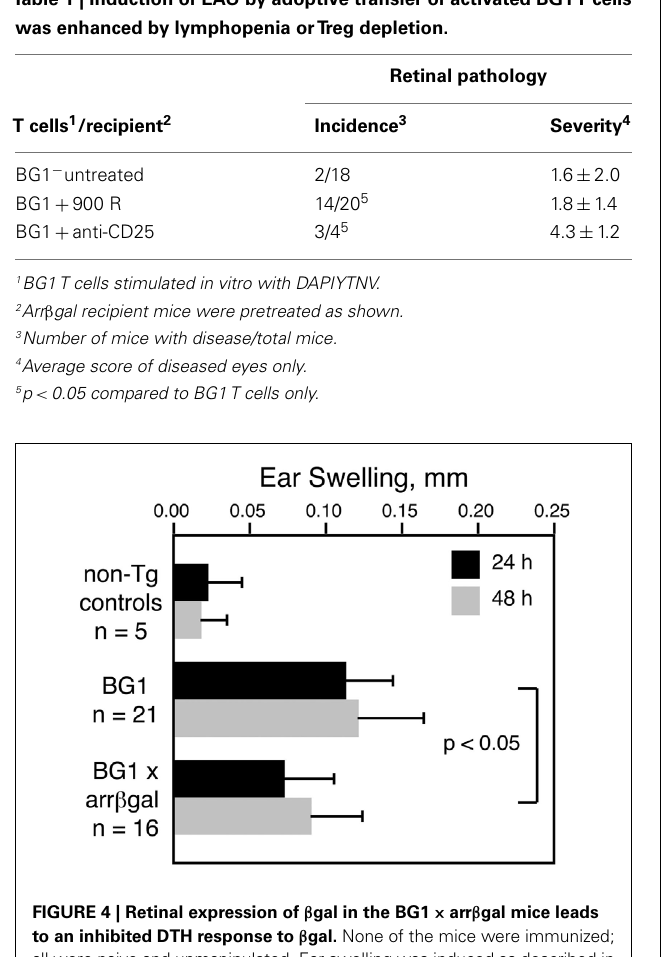
FIGURE 5 | β gal-specificTregs modulate the DTH response of β gal-specific CD8 + T cells. (A) Flow cytometry ofTregs (CD4 + GFP + T cells) in Foxp3-GFP mice following i.v. injection of 100 µ g BSA or β gal. (B) Ear swelling assay in BG1 mice transferred with 5 × 10 5 totalTregs (GFP + cells) from the BSA or β gal-injected Foxp3-GFP mice shown in (A) . Ear pinna injections with β gal were done immediately after transfer of the GFP + Tregs. (C) Depletion ofTregs by systemic DTx treatment increases the DTH response of CD4 + and CD8 + T cells to β gal. DTx (250ng/injection) was given i.p. on days 0, 3, and 6. β gal was injected into the ear pinna on day 7 to start the DTH response. Ear swelling was read on days 8–10. Results are given as the mean ± SD with P values determined by t